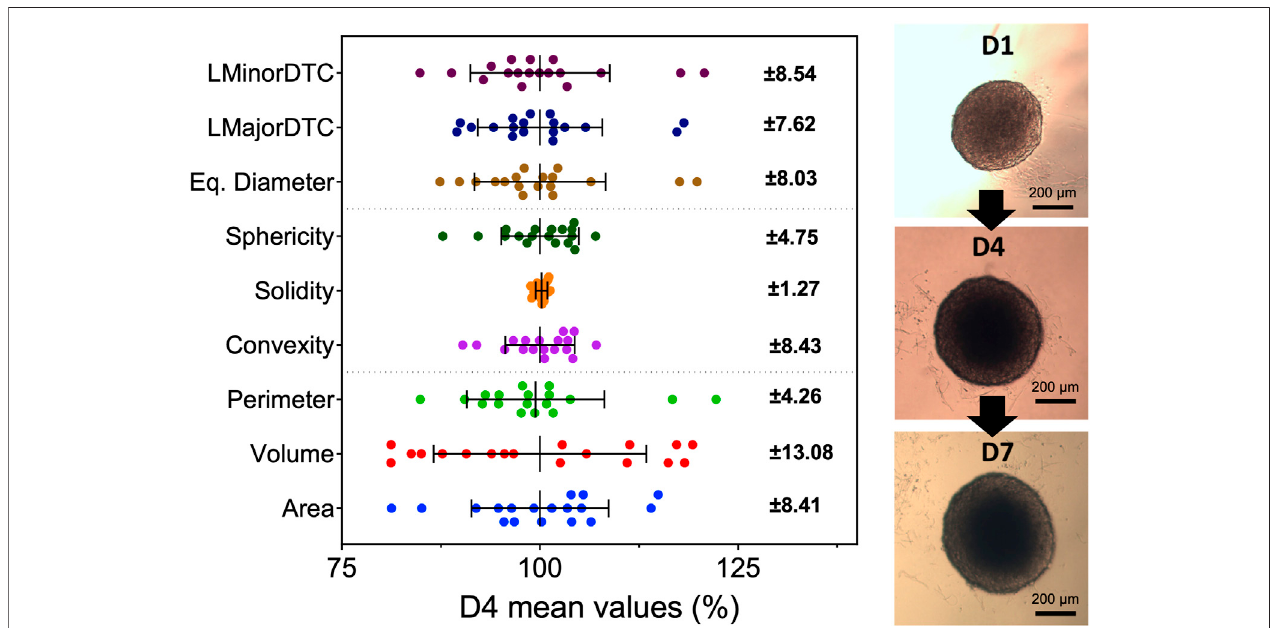
FIGURE 2 | Spheroids show variability in all morphometric parameters at all time points during growth. Parameters were obtained with wide fi eld microscopy images and AnaSP with spheroids at day 4 after seeding ( N (cid:1) 3, n (cid:1) 6). Error bars represent standard deviation from the mean value of all samples (shown on the right). Each point represents a single spheroid before selection for PDT. Sphericity, area, and equivalent diameter were chosen to pre-select samples before continuing to in vitro PDTevaluation.Although solidityhad lowvariation, itwasnotpossible todistinguish betweenhealthyand damagedsamples.Spheroidscontinued togrow and maintain their morphology past day 7, reaching around 600 µm in